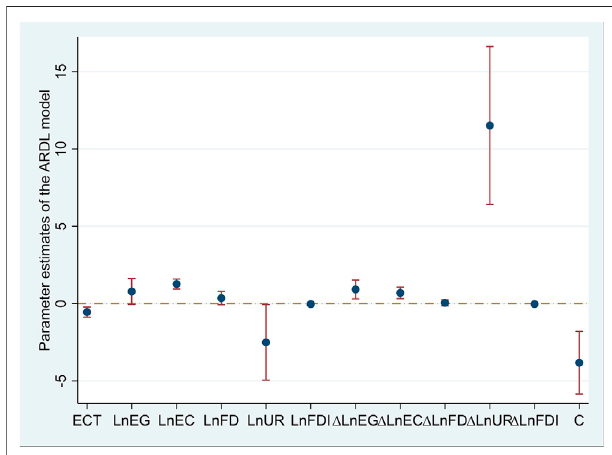
FIGURE 2 | Parameter estimates of the ARDL model. Notes: the estimate in a log-log model is shown by the blue (